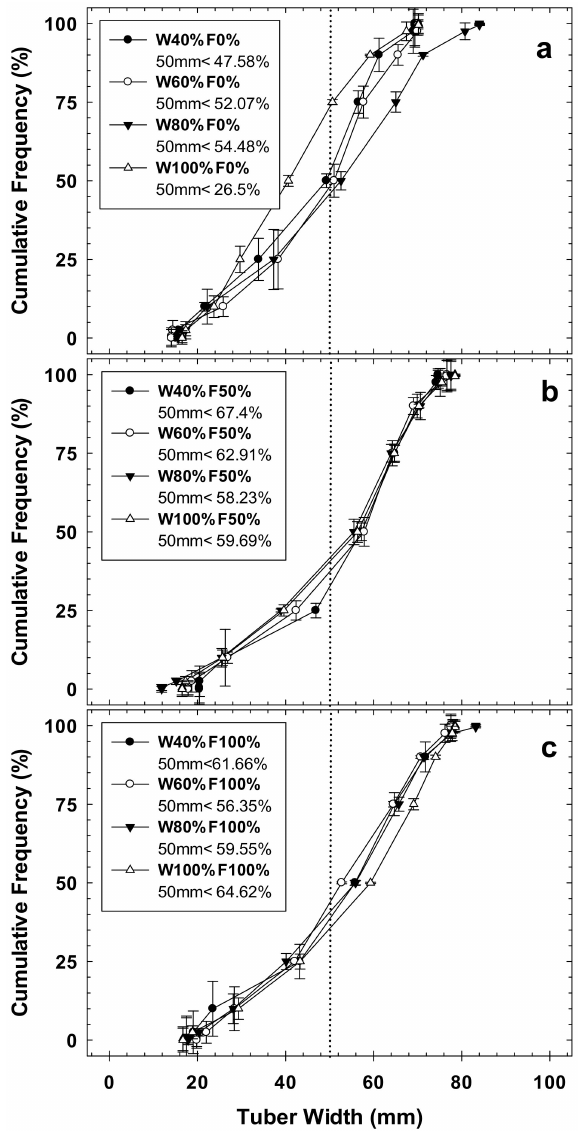
Figure 5. Cumulative frequency of tuber width according to the treatments. ( a ) F0%; ( b ) F50%; ( c )